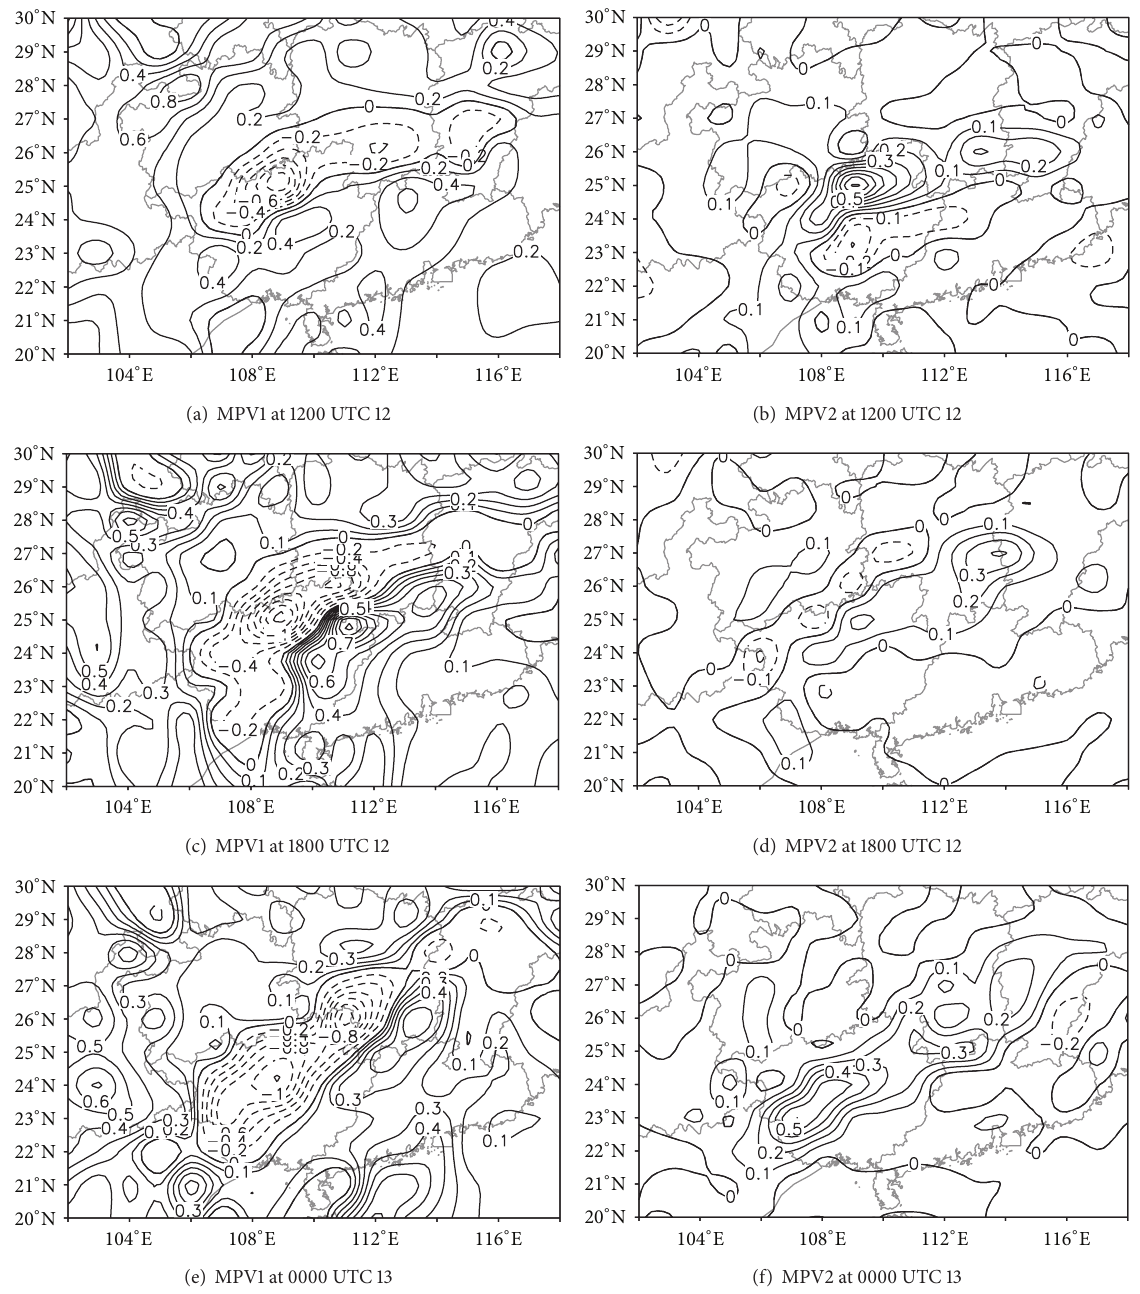
Figure 9: Spatial distribution of (a, c, e) MPV1 and (b, d, f) MPV2 at 850 hPa during the SWV development. Their unit in PVU (1PVU = 10 −6 m 2 ⋅ K ⋅ s −1 ⋅ kg −1